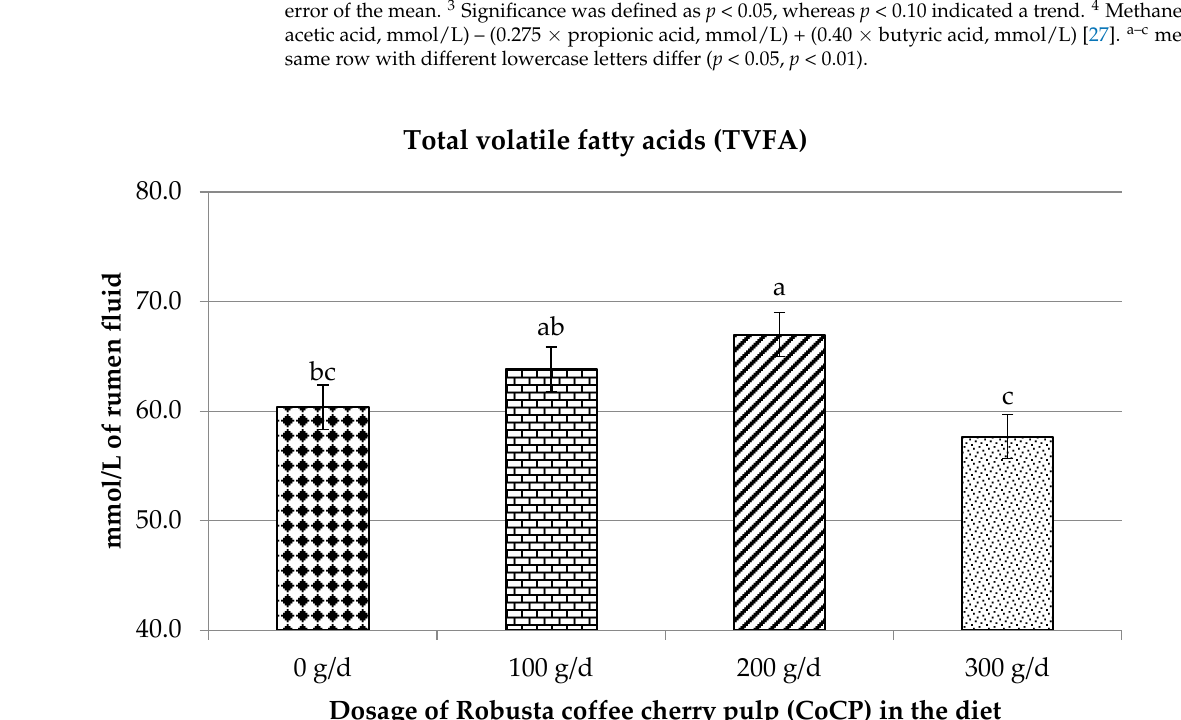
Figure 1. Effects of dietary CoCP supplementation (g/d) on total volatile fatty acids (TVFA) of Thai crossbred goats. a–c means in the same row with different lowercase letters differ ( p < 0.05, p < 0.01).